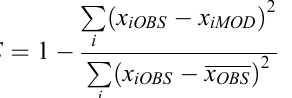
heat flux ( G ), surface temperature ( T ), and soil water storage s (